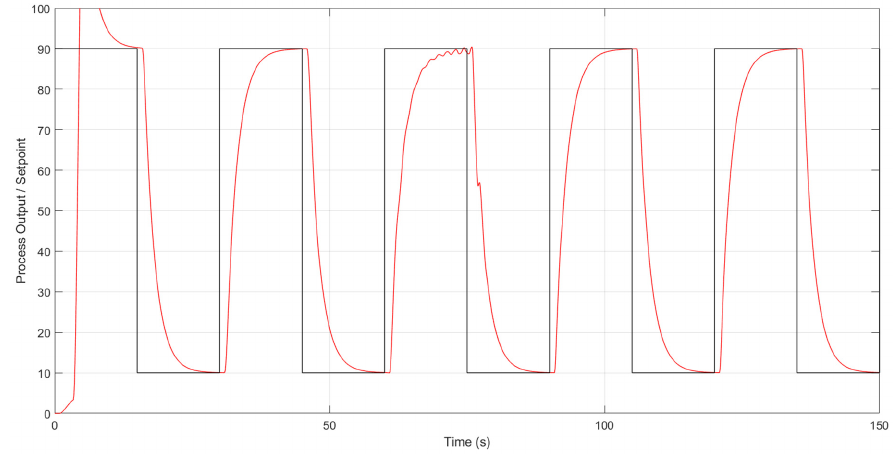
Figure 5. Tracking performance of the controller in the unconstrained case. Red: process output; black: setpoint.